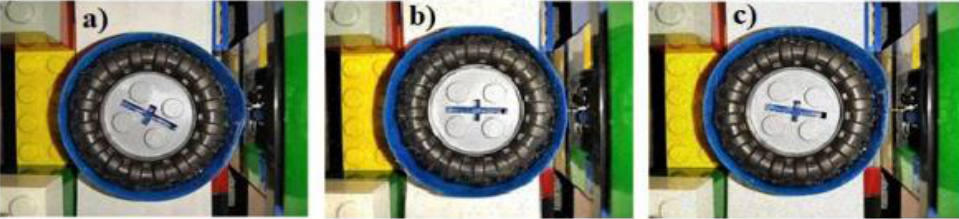
Figure 8. Noise application: ( a ) Gaussian, ( b ) S&P, ( c ) speckle.